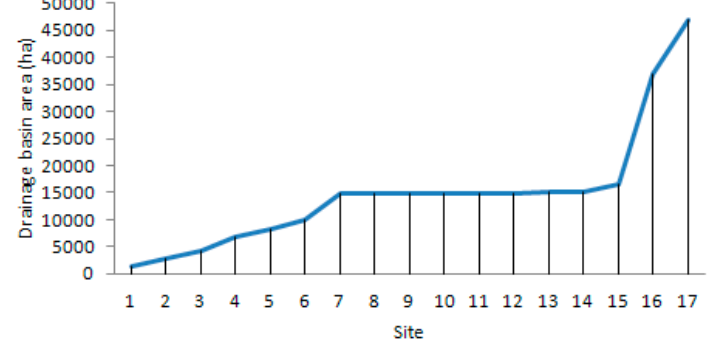
Figure 2. Increase of the drainage basin area of the Corgo river (ha) in the examined sites.